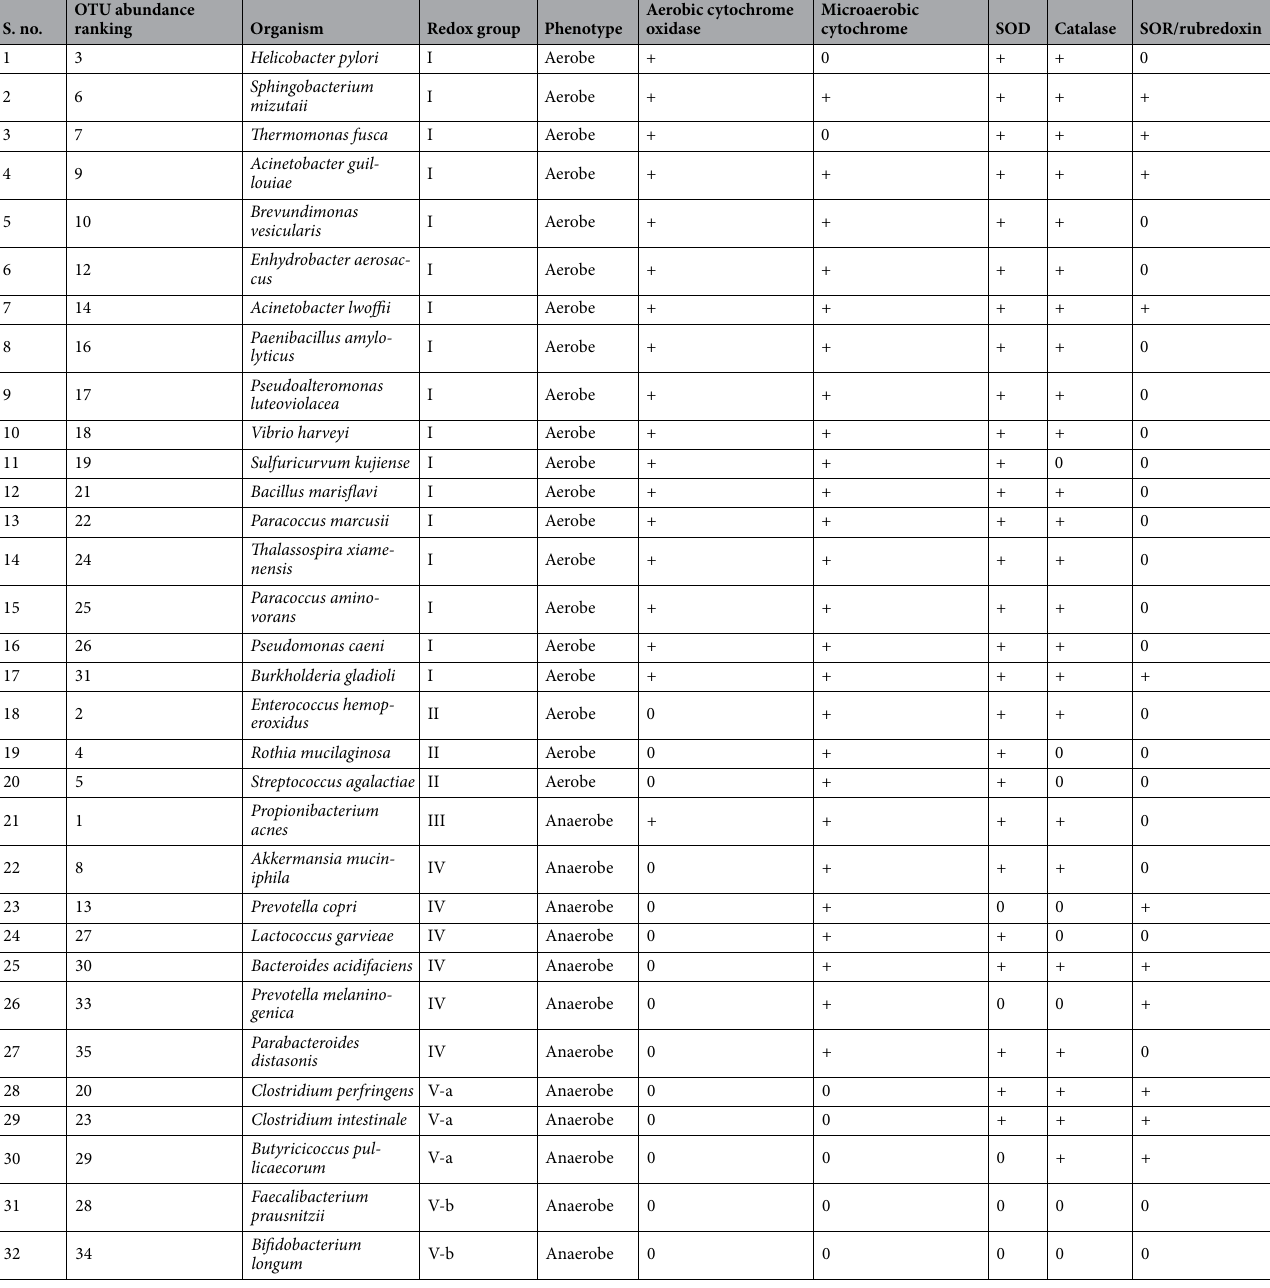
Table 2. Redox categorization of gastric mucosal